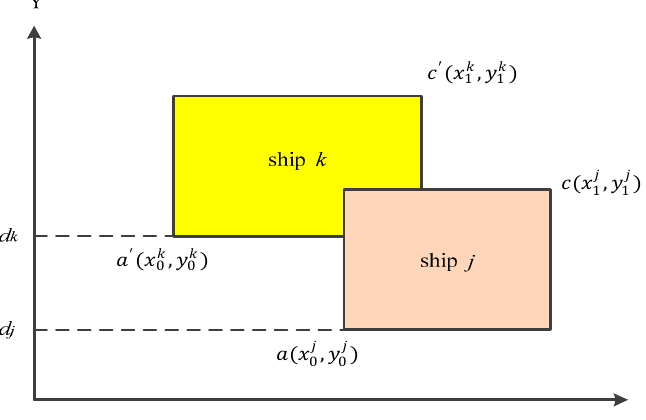
Figure 3. The coordinates of two corners of the ships j and k.